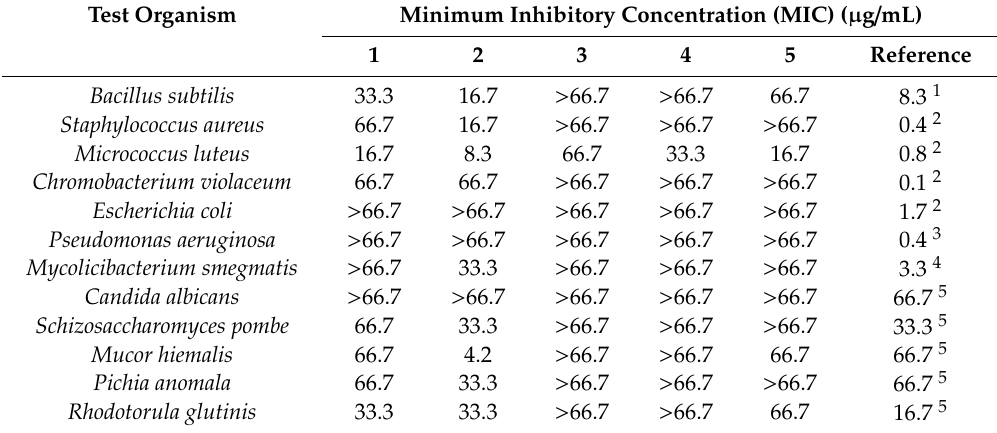
Table 2. Minimum inhibitory concentrations (MIC) of 1 − 5 against bacterial and fungal test organisms. Test Organism